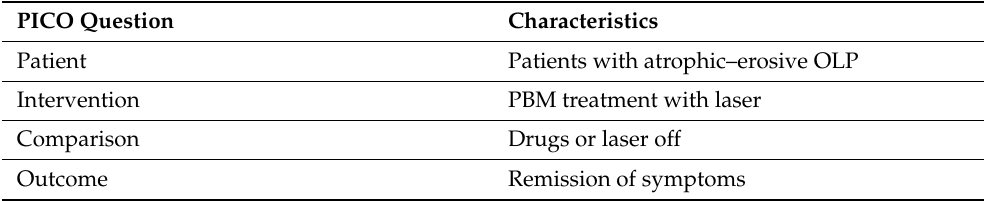
Table 1. Components of the PICO